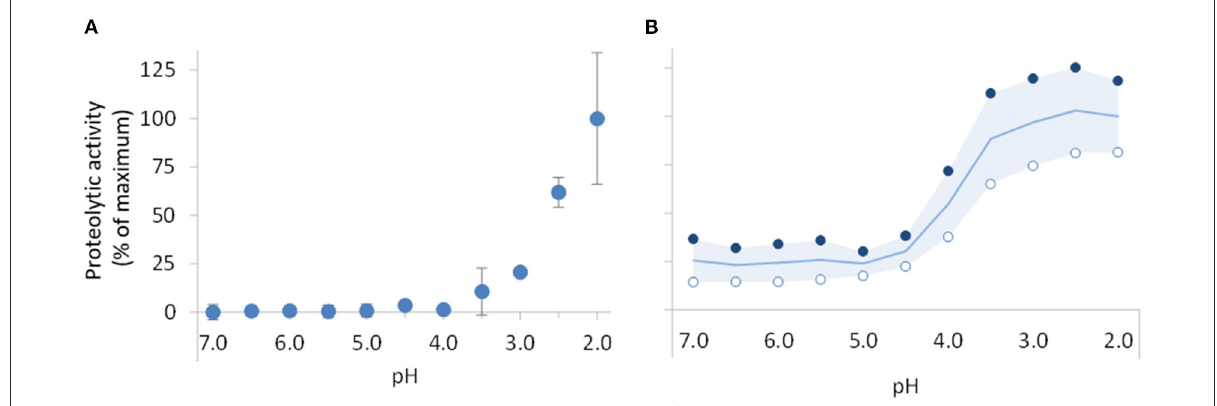
FIGURE2 Impact of gastric pH reduction on the proteolytic activity of pepsin (A) and supplemental enzyme mix (B) . Proteolytic activity was determined using the pepsin activity assay recommended by INFOGEST (25) adapted to consider the different pH levels. Results are presented as percentage of the maximum activity, 3509 ± 687 and 240 ± 62 U/mg, respectively, for pepsin and supplemental enzyme mix, obtained with the standard protocol at pH 2. In chart (A) , data points are mean of 3 assays with pepsin ± SD. In chart (B) , open ( ◦ ) and filled (•) circles correspond to series of results, respectively, obtained with the supplemental enzyme mix at concentrations of around 100 µ g/mL and 1,000 µ g/mL. The line and the colored area in this chart represent the mean of these data series and respective